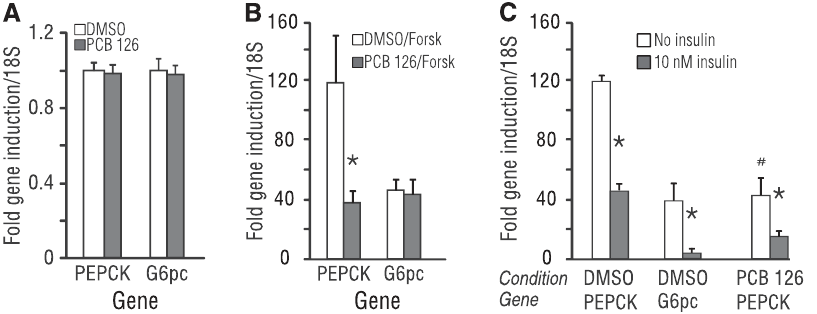
Figure 3. Differential impact of PCB 126 on key forskolin-responsive gluconeogenic genes. (A) PCB 126 has no effect on basal PEPCK or G6Pc expression. (B) PCB 126 selectively suppresses forskolin induction of PEPCK gene expression, but not that of G6pc. (C) Insulin strongly suppresses forskolin induction of PEPCK, and the effect of PCB 126 is additive with that of insulin; *p , 0.05 for insulin effect within each condition and gene, # p , 0.05 for PCB 126 effect on PEPCK induction independent of insulin. All PCB 126 treatments were 16 h in length while forskolin (25 m M) and insulin (10 nM) were added at the start of the assay. Data are average of 3 experiments for panels A–B, and 2 experiments for panel C; error bars are 2 / + SD.